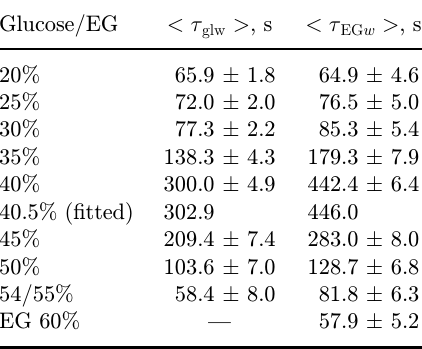
Table 1. Di®usion time values obtained for glucose and EG treatments.